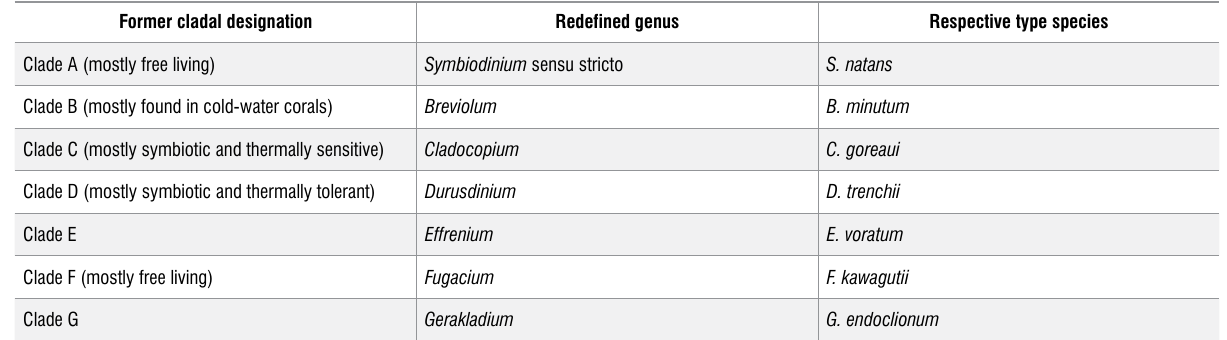
Recently redefined taxonomic designations of the well-known zooxanthellae clades into seven genera and their respective type species 6